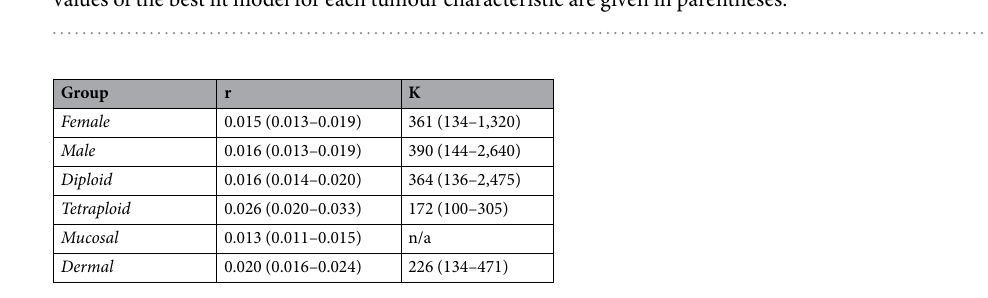
Table 2. Parameter estimates for growth rates per day (r) and maximum tumour volume (K) for each sex, ploidy and location. Numbers in brackets are central 95% Bayesian credible